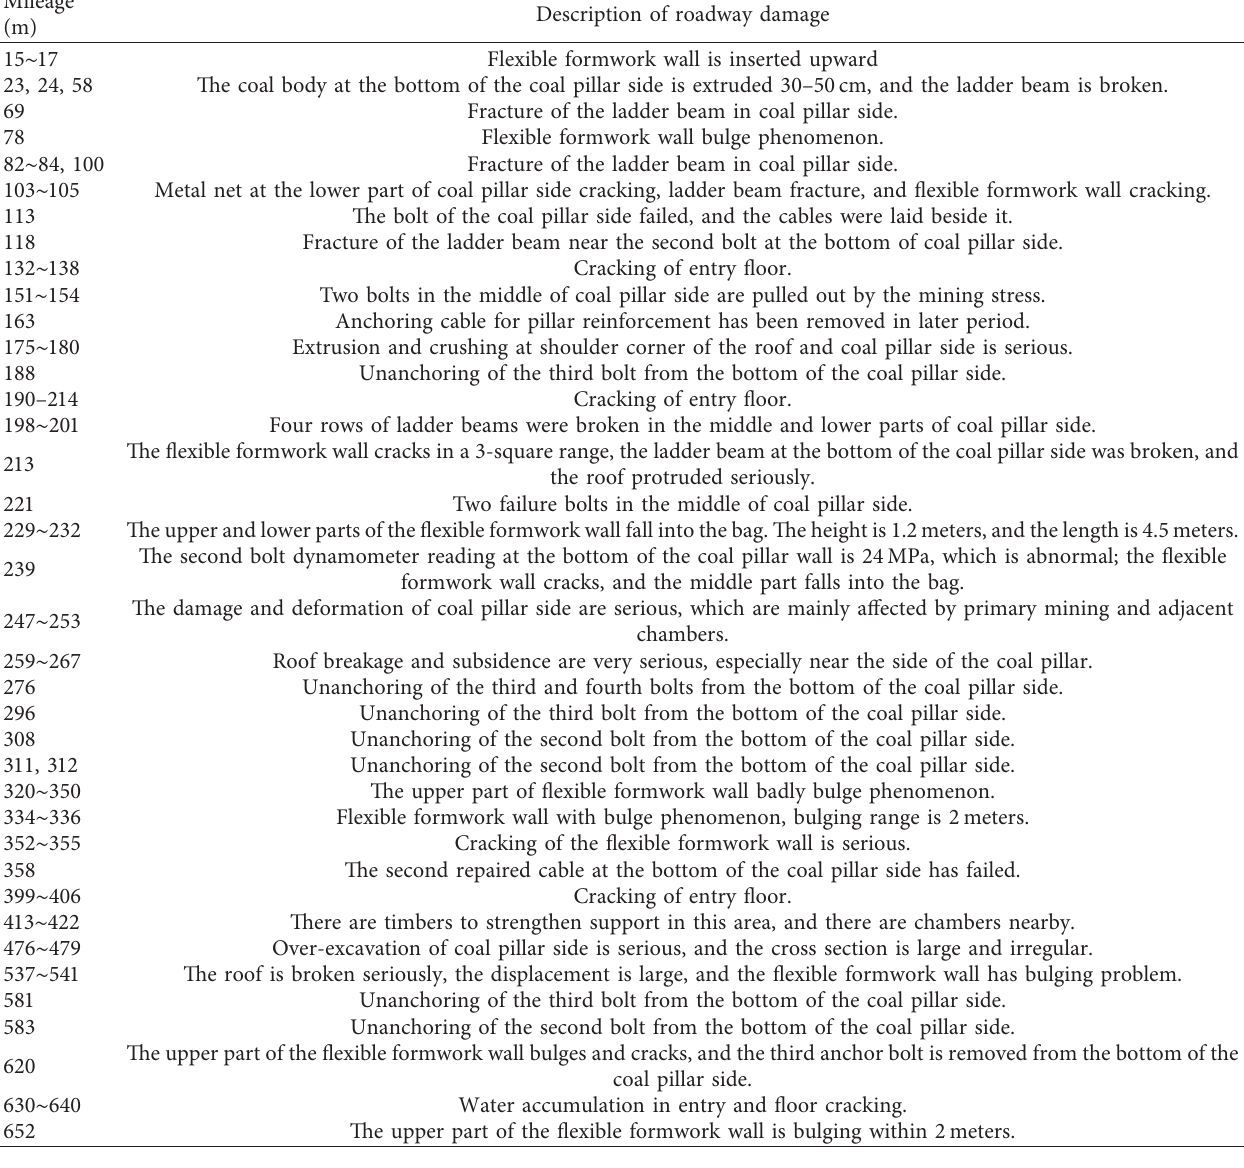
Table 9: Questionnaire on deformation and failure of E1316 intake entry.